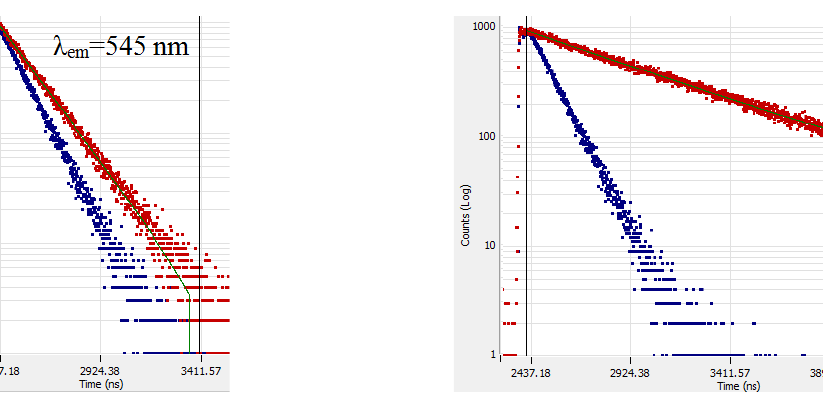
Figure 5. Energy diagram of Tm 3+ and Bi 3+ ions with experimentally observed transitions in the vis- ible and infrared regions at T = 80 K.